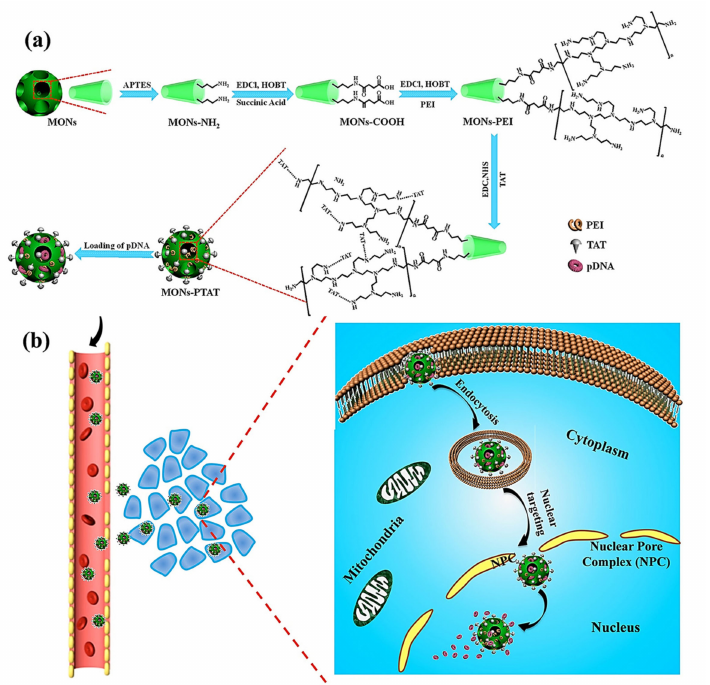
Figure 5. ( a ) Schematic representation of TAT-targeted MSNs for nucleic acid transfection. The plasmid was loaded into the PEI-TAT mesh, leading to enhanced nuclear accumulation and encoding green florescence protein through a model plasmid. ( b ) Schematic representation of the mode of action of the nanocarrier. Reproduced from Ref. [94] with permission from